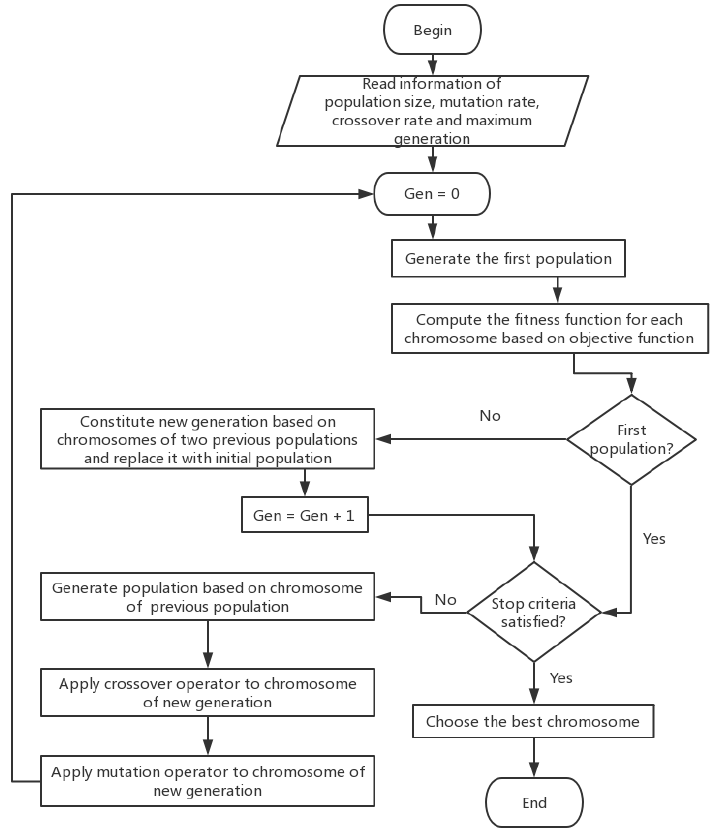
Figure 1. Schematic diagram of the genetic